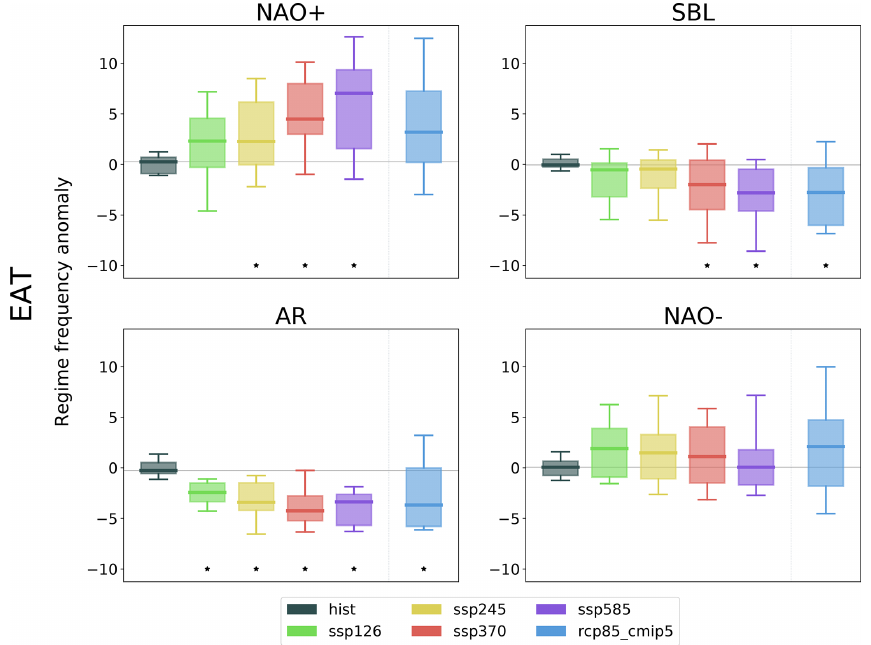
Figure 4. Whisker plots of the multi-model distribution of WR frequencies in the CMIP6 historical (1964–2014) and future (2050–2100) reference periods with respect to the historical regime frequency. The boxes indicate the first and third quartiles, the horizontal bar indicates the median, and the top and bottom bars indicate the 10th and 90th percentiles. The black star at the bottom indicates a significant difference at the 95% level with respect to the historical distribution using Welch’s t test.